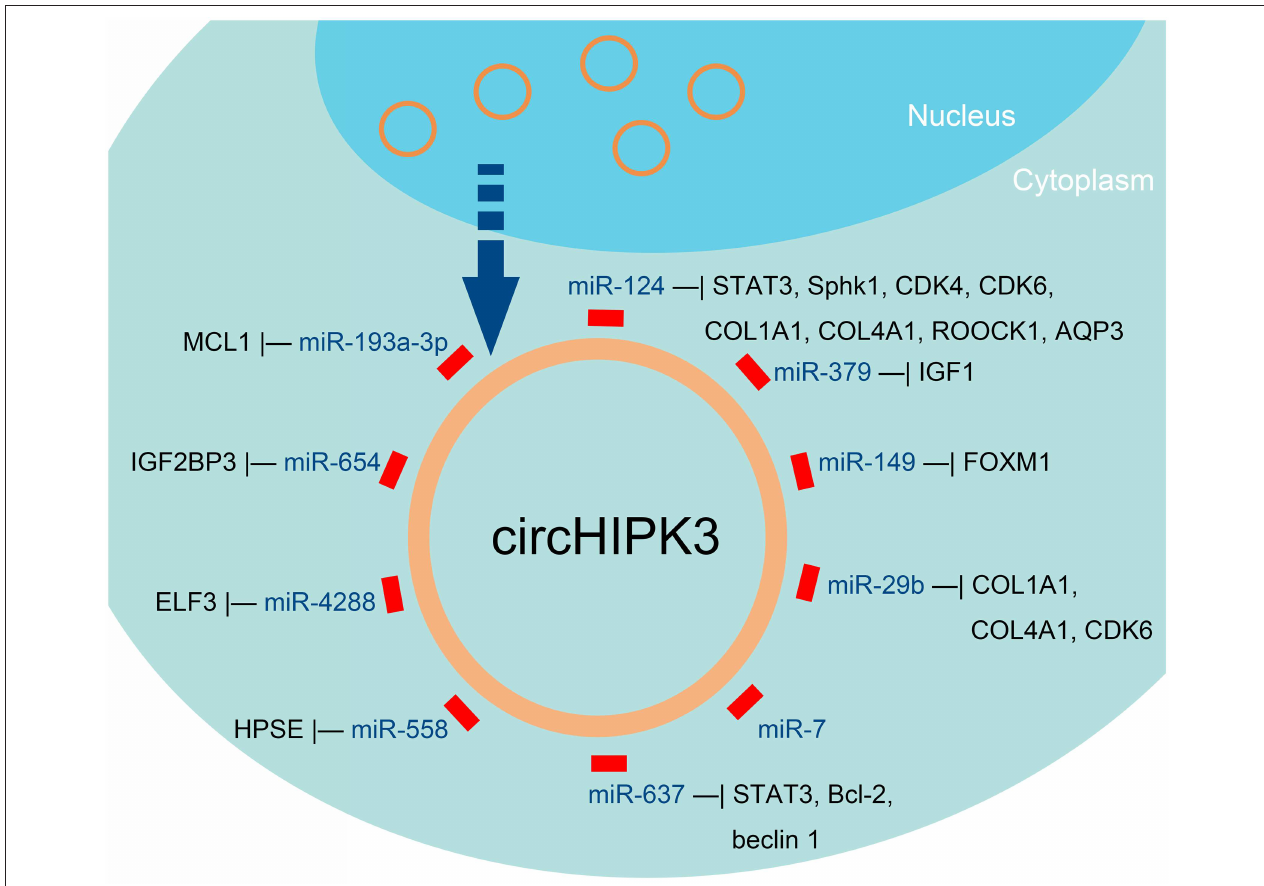
FIGURE 3 | miRNAs that can be sponged by circHIPK3, according to published reports about human cancers.